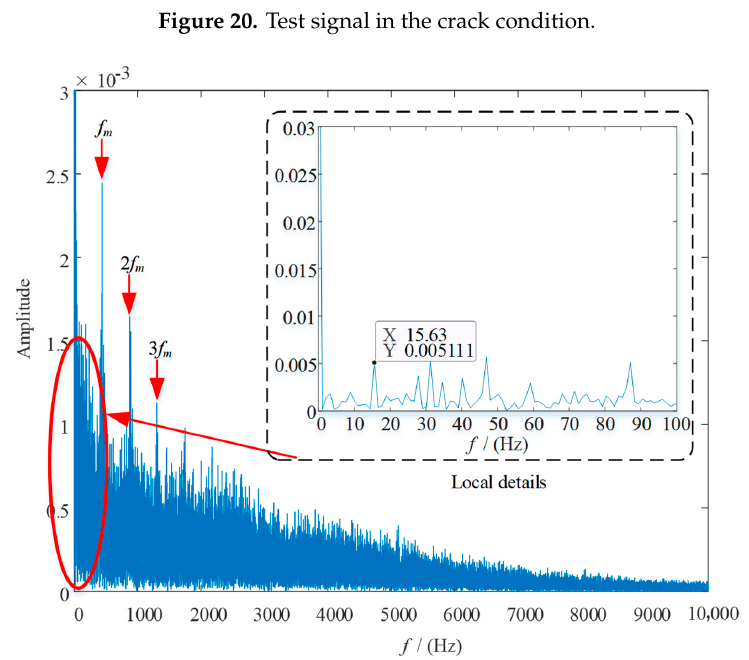
Figure 20. Test signal in the crack condition.